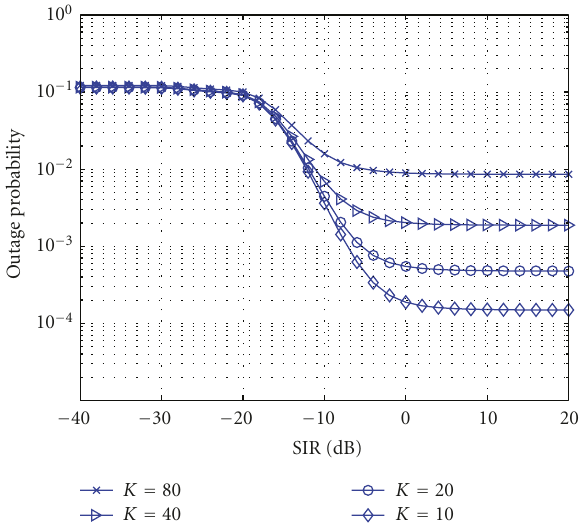
Figure 8: Outage probability of a DS/FH system; Impact of the number of interferers, the number of antenna elements M = 2, processing gain G DS = 50, the number of users K = 40, duty cycles of interferes are ρ 1 = ρ 2 = ρ 3 = 0 . 2, SNR Γ N = 100 dB, the number of hopping channels N = 10, the number of multiple path L = 3, decay factor δ = 0, and protection ratio r th = 3dB.